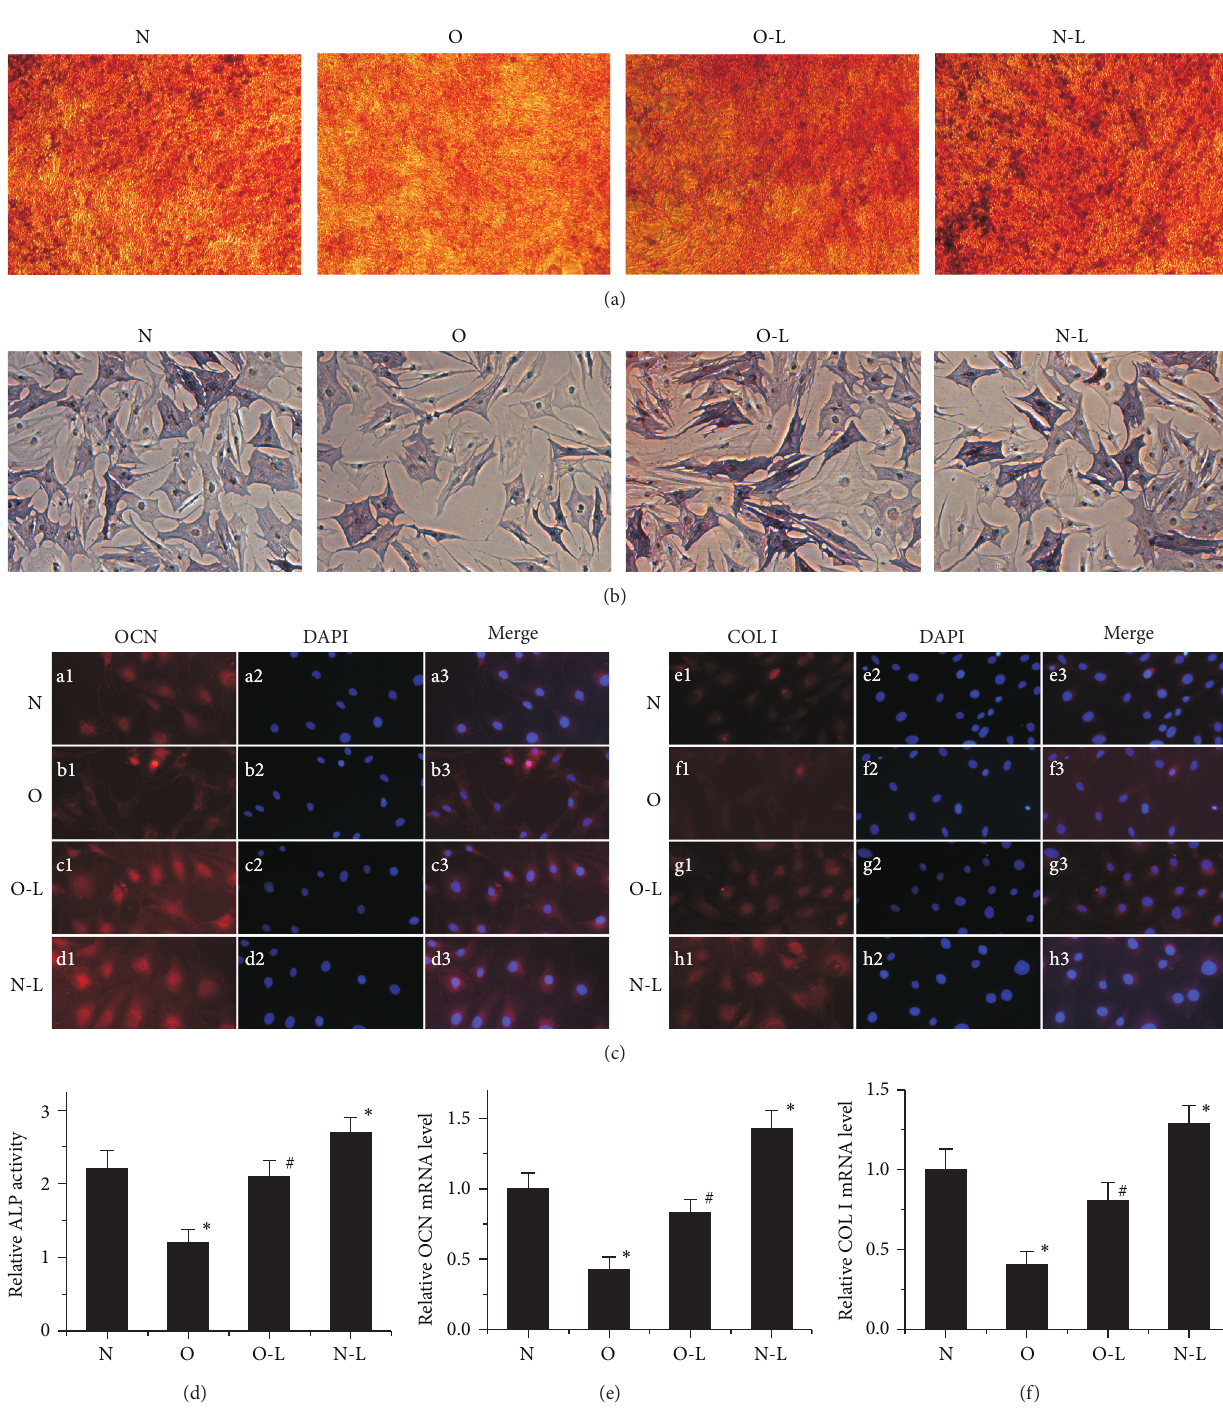
Figure 4: Effect of low oxygen (2%) on MSC osteogenic differentiation. (a) The mineralization nodes were monitored by Alizarin Red S staining 14 days after cells were induced in an osteogenic induction medium. (b) Alkaline phosphatase staining of MSCs after osteogenic differentiation. (c) Immunostaining for OCN and COL I (Texas-Red, a1-h1) with nuclear counterstained (DAPI-blue, a2-h2) 2 weeks after osteogenic differentiation ( × 400). (a3-h3) Merge. (d) ALP activities in BMSCs. (e) OCN mRNA expression was examined by RT-PCR at day 14. (f) COL I mRNA expression was examined by RT-PCR at day 14. The data were drawn from three independent experiments and the results were expressed as mean ± SD. ∗ 𝑃 < 0.05 versus N Group. # 𝑃 < 0.05 versus O